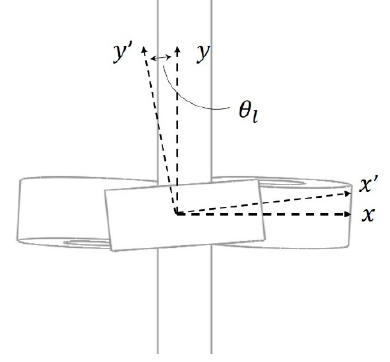
Figure 4. The lead angle. Figure 4. The lead